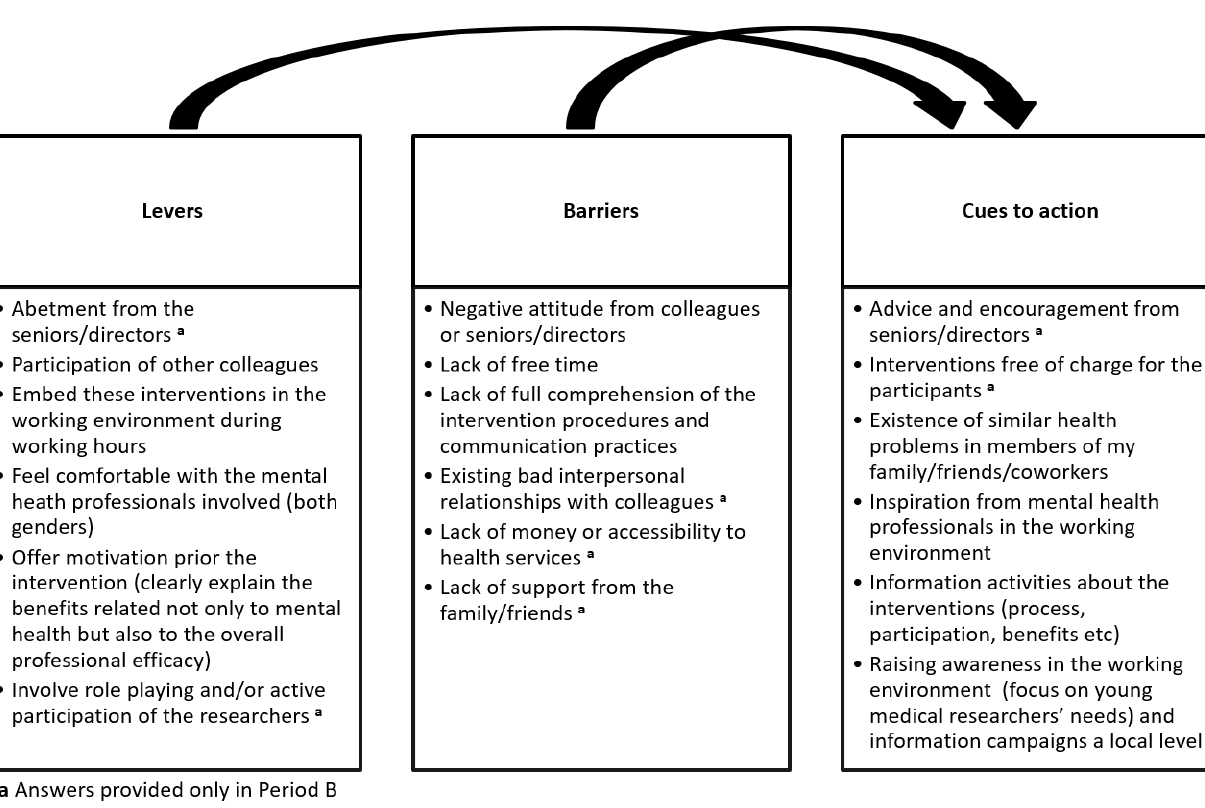
Figure 1. Levers, barriers and cues to action in tackling distress and burnout through participatory interventions before and during the financial crisis.